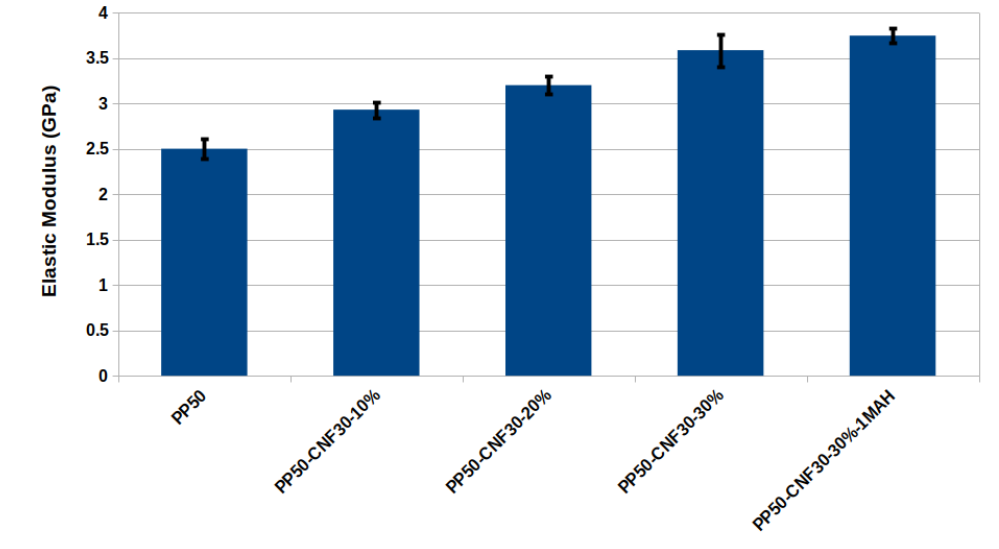
Figure 10. The elastic modulus for pure PP and elastic modulus for several CNF-PP bionanocompos- ites in the x and y -directions perpendicular to CNF). The PP density in each model is in the range of 0.83–0.85 g cm − 3 , which matches the experimental values. The model with the -1MAH suffix has a maleic anhydride coupling agent covalently bonded to both PP and